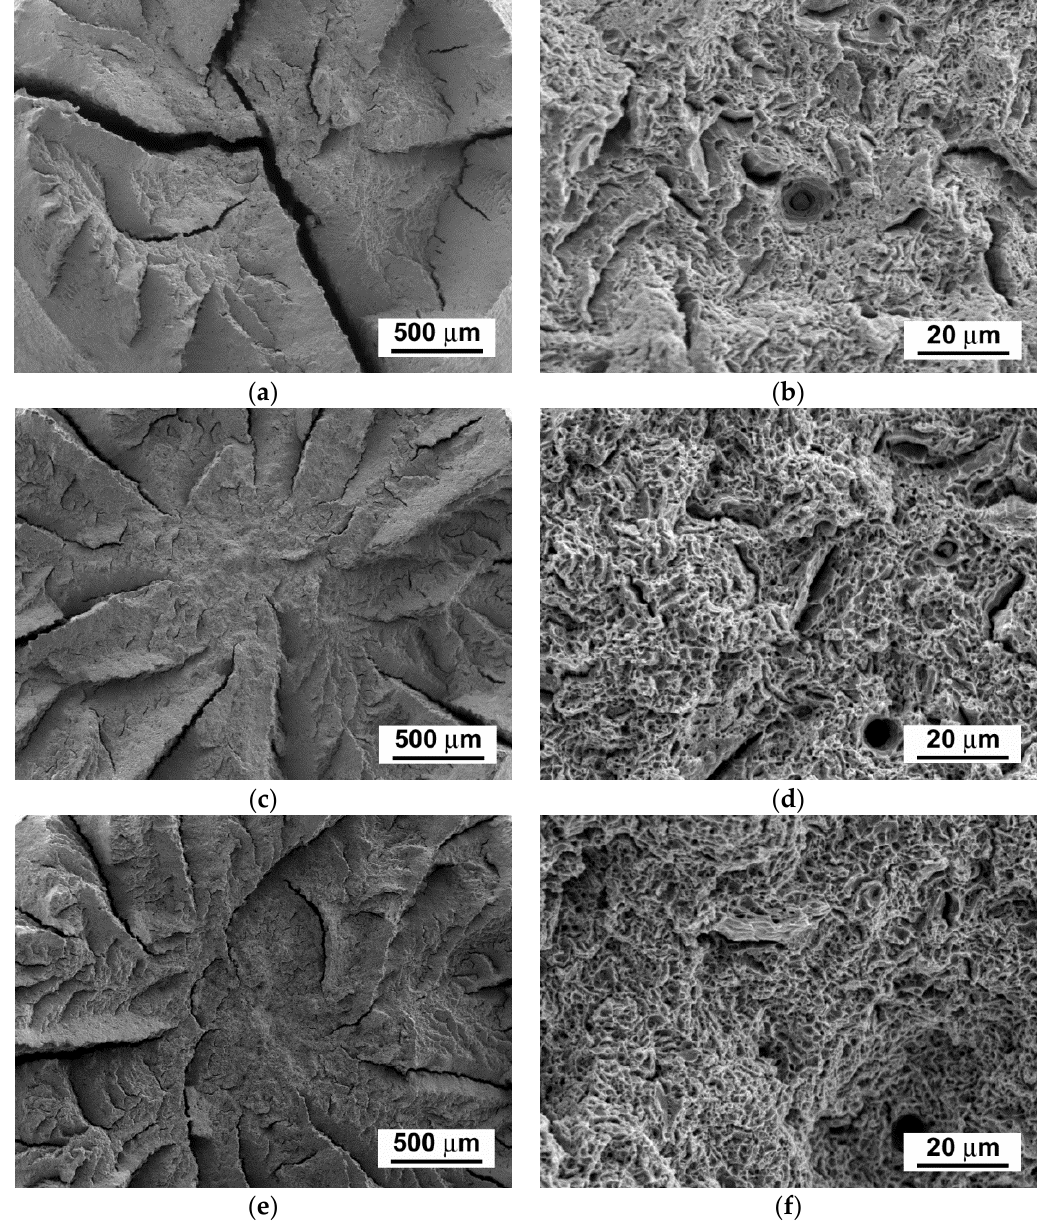
Figure 9. SEM fractographs of fractured tensile test specimens after quasi-static tensile tests of P92 steel in various material conditions: ( a , b ) N&T, ( c , d ) 600 °C/2.5 kh, and ( e , f ) 600 °C/5 kh.